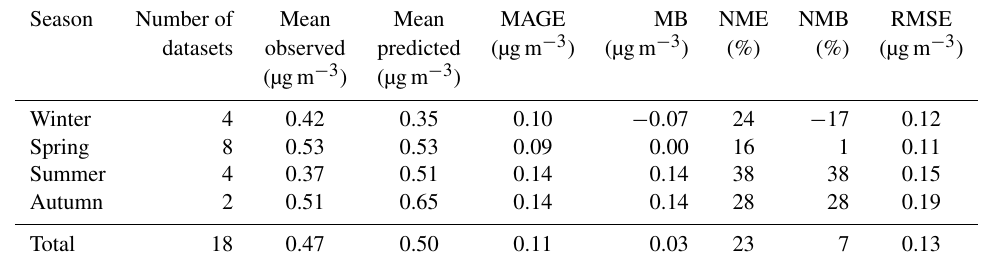
Table 7. Statistical evaluation of EMAC O:C ratio of total OA against observations from 18 datasets worldwide during 2001–2010. Season Number of Mean Mean MAGE MB NME NMB RMSE datasets observed predicted